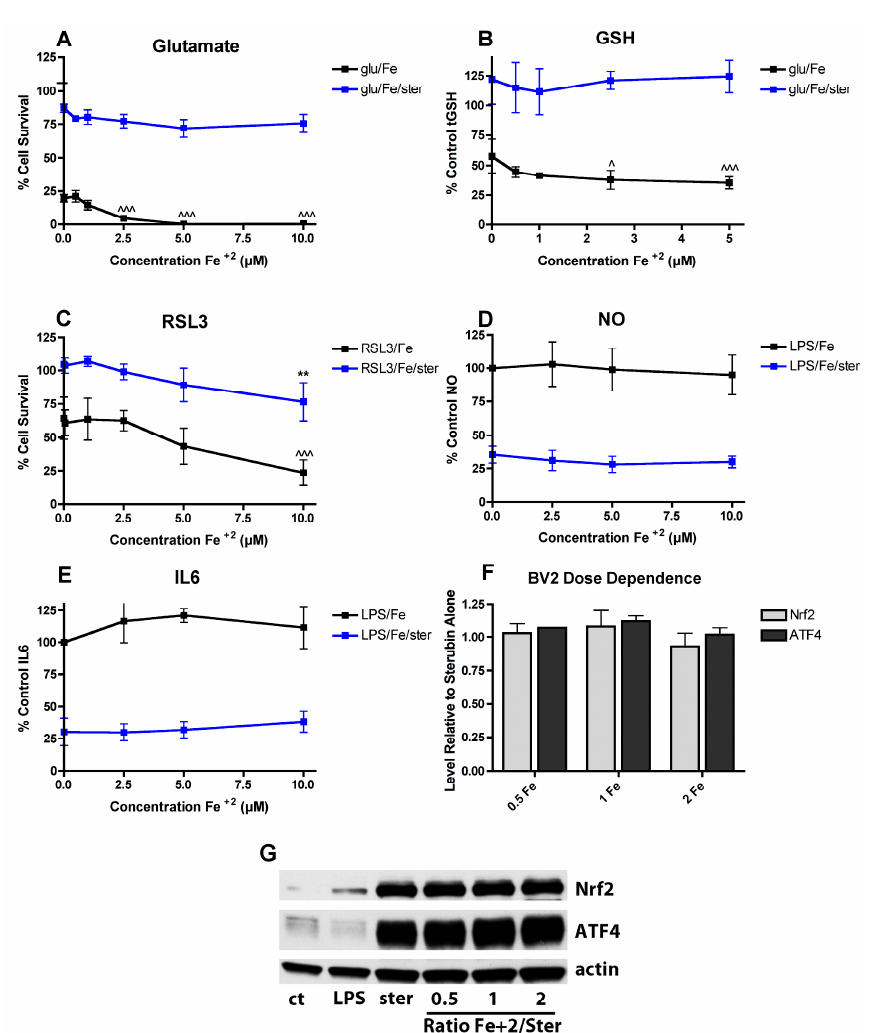
Figure 7. FeCl 2 does not interfere with the activities of sterubin. ( A ) FeCl 2 does not alter the protective e ff ect of sterubin against glutamate toxicity. HT22 cells were treated with 2.5 mM glutamate in the presence of 5 µ M sterubin and / or FeCl 2 at the indicated concentrations. Cell survival was measured after 24 h with the MTT assay. The experiments were done in quadruplicate and the results are the average of 4 independent experiments. ( B ) FeCl 2 does not a ff ect the maintenance of GSH levels by sterubin. HT22 cells were treated with 2.5 mM glutamate in the presence of 5 µ M sterubin and / or FeCl 2 at the indicated concentrations. Cells were harvested after 24 h and total GSH was